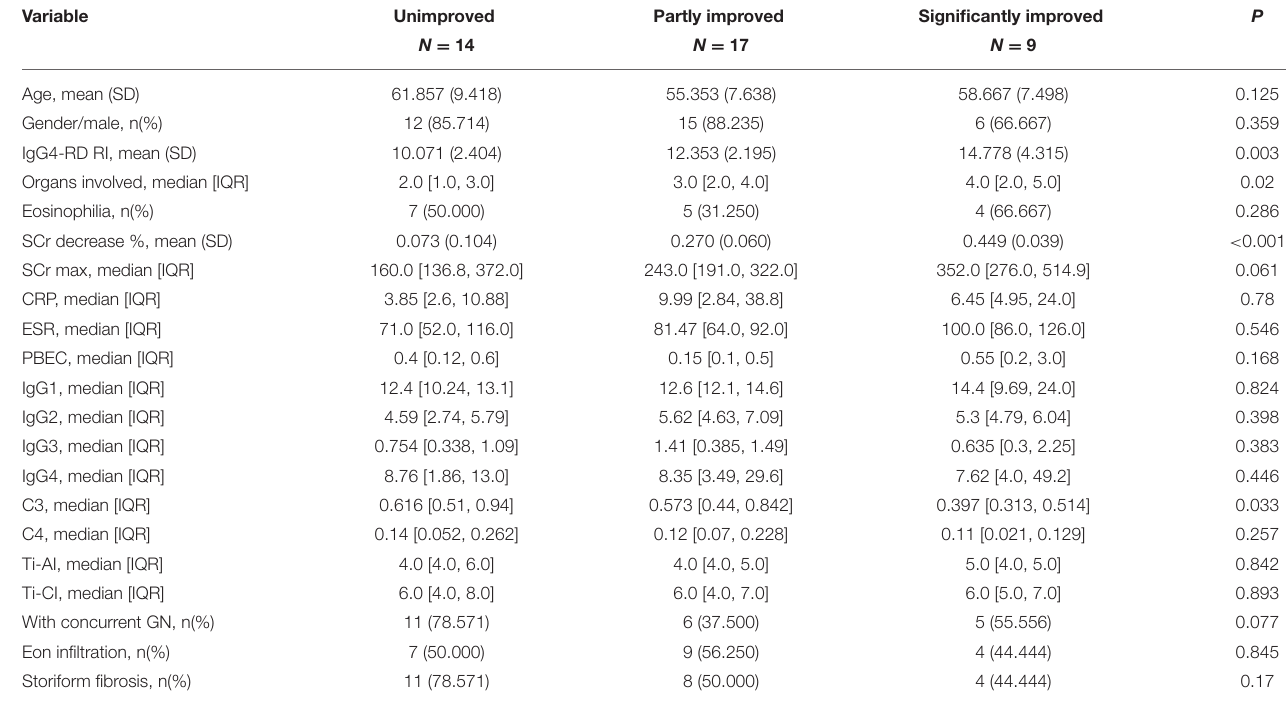
TABLE 3 | The affecting factors to percentage decrease of Scr at 1 month. Variable Unimproved Partly improved Significantly